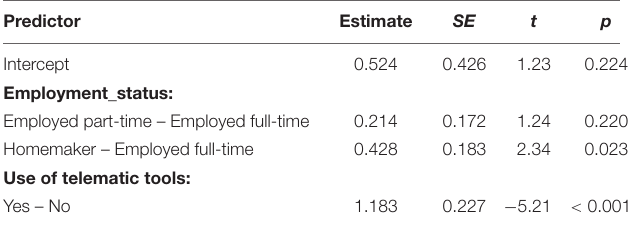
TABLE 5 | Linear regression model on total scores of the questionnaire for families.